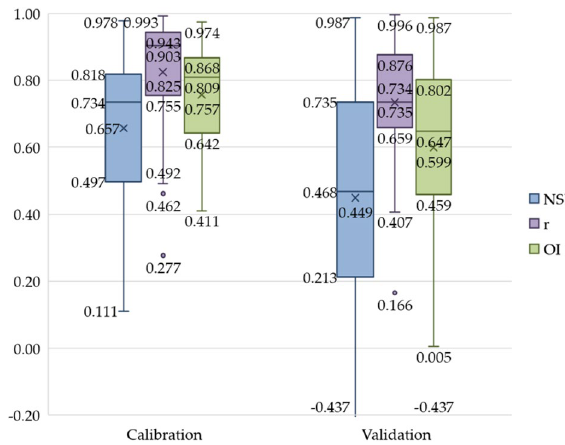
Figure 5. The results of model’s calibration and validation.